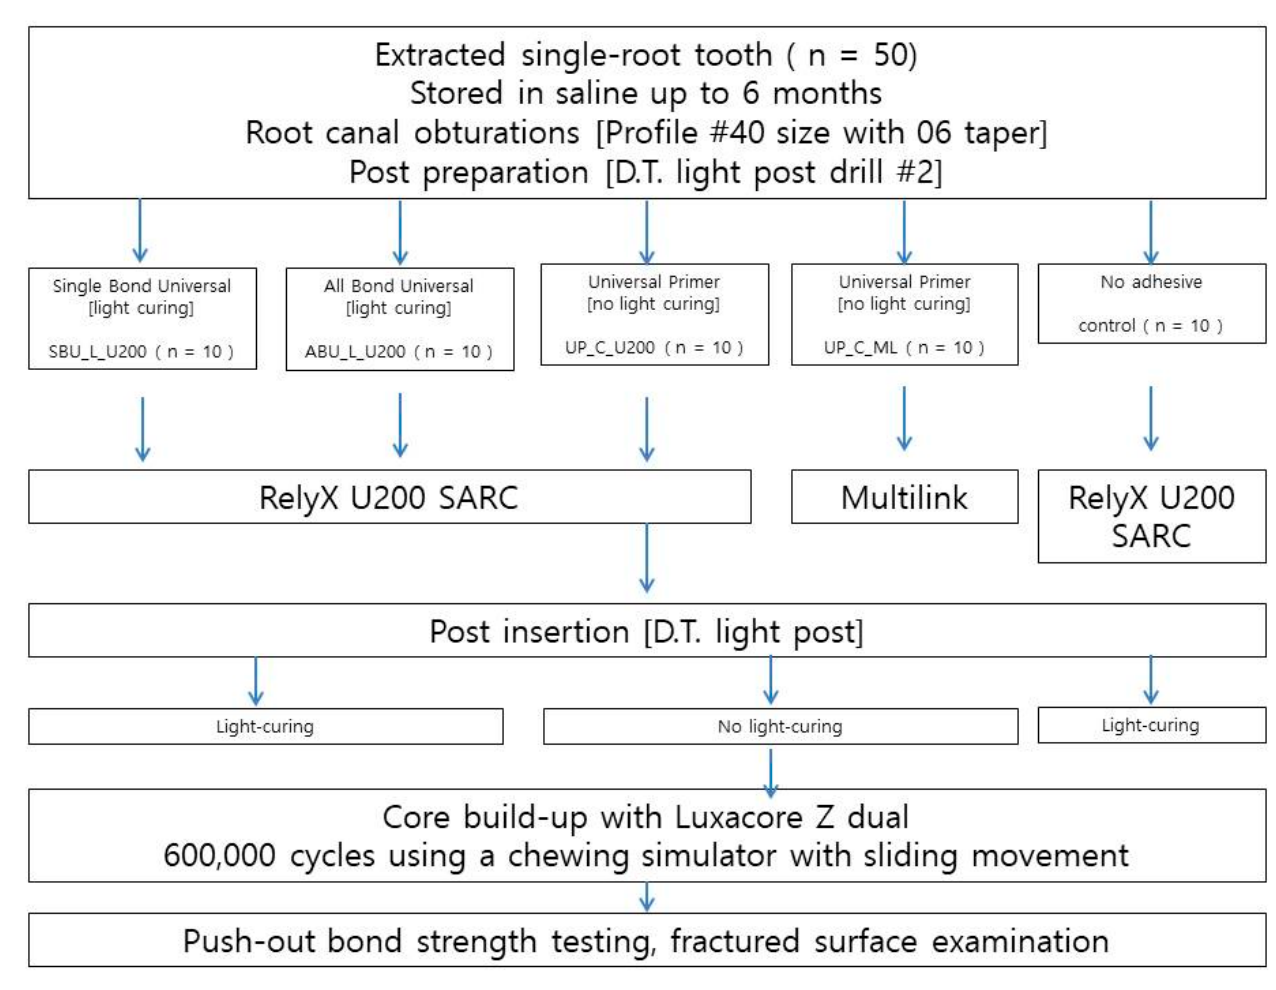
Figure 1. Flowchart of the cementation procedure for the